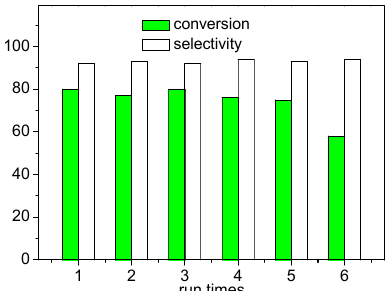
Figure 5. Recycling of the Fe 3 O 4 @PDA@Pd catalyst in oxidative dehydrogenation of benzyl alcohol.